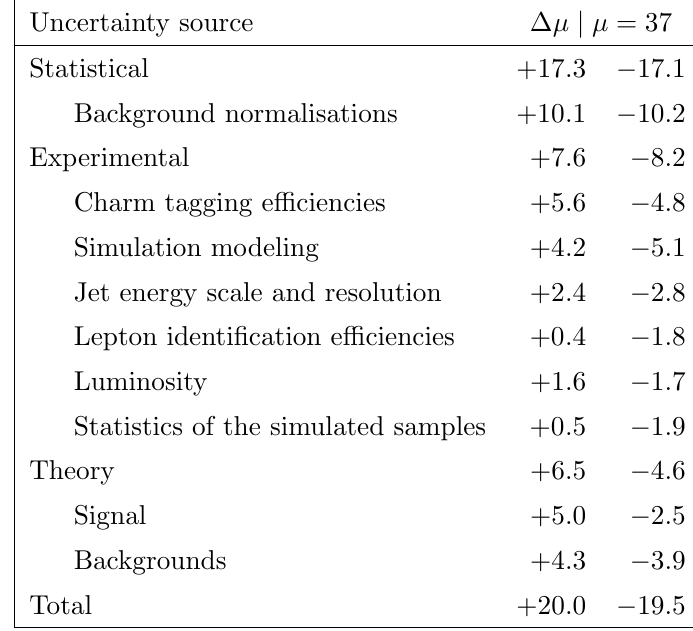
Table 4 . Summary of the impact of the statistical and systematic uncertainties on the signal strength modi(cid:12)er for combined analysis of the resolved-jet and merged-jet topologies.